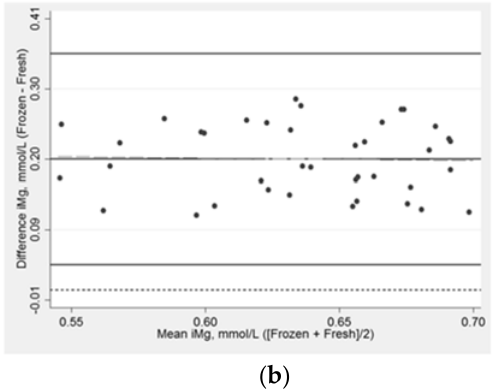
Figure 3. Bland-Altman plot assessing the ( a ) association between ionized magnesium concentrations at baseline in fresh whole blood and in serum after refrigeration, n = 39; ( b ) the association between ionized magnesium concentrations at baseline in fresh whole blood and in serum following one freeze–thaw cycle, n = 39. Normalized iMg concentration, which is adjusted for blood pH. The median time in the fridge = 71 min. The median time frozen = 81 days. Solid lines (black) are the mean difference ± 3 standard deviations; the long dash line (gray) is the fitted values; the short dash line (black) is the reference line for the mean difference of 0 mmol/L. Table 3. Mean ionized magnesium concentrations in fresh, refrigerated and frozen blood samples and mean difference from baseline (fresh) after refrigeration and freezing, n = 39. Time from Draw to Analysis 1 pH